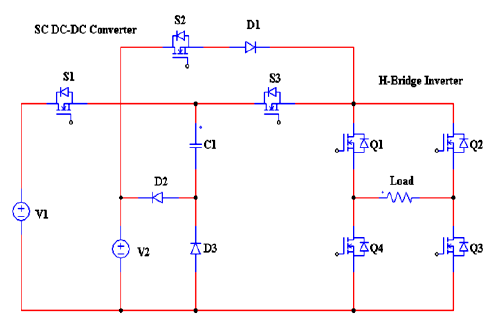
Figure 10. MLI based on switched capacitor.